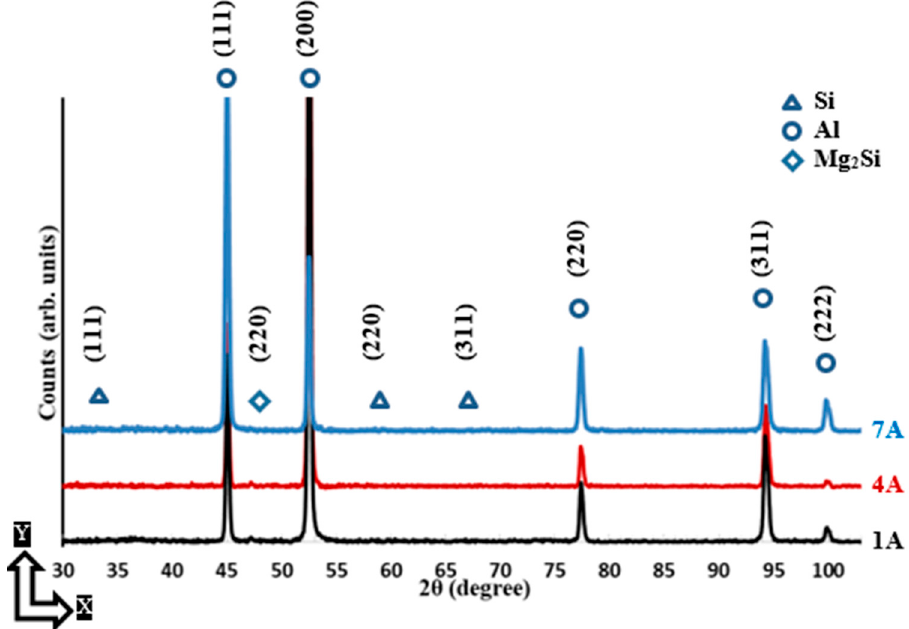
Figure 9. XRD phase pattern measured on the top surface (along the XY plane) of different as-built AlSi10Mg samples.